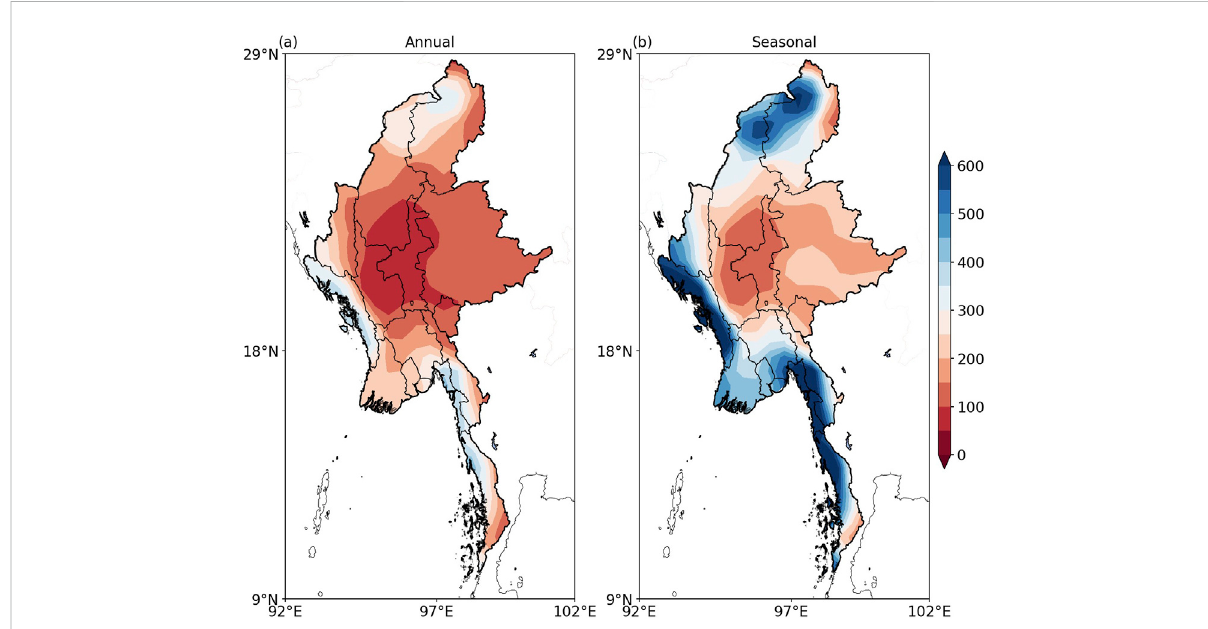
FIGURE 2 Spatial distribution of GPCC precipitation observations for (A) annual (B) seasonal during 1970 – 2014